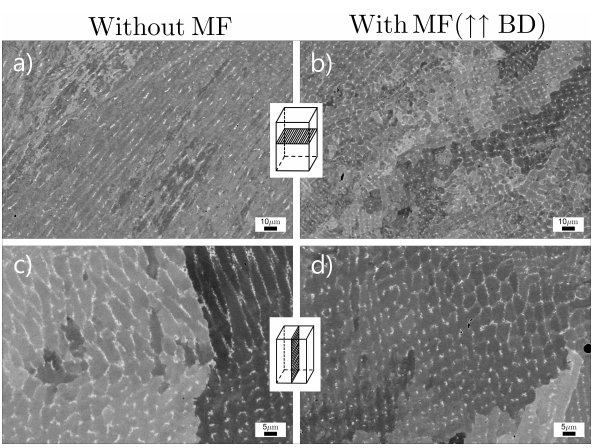
Figure 8. BSE images of the as-deposited Inconel 718 samples in various investigated planes: ( a , b ) top and ( c , d ) front, and no ( a , c ) and with ( b , d ) applied vertical MF. The estimated cell sizes are as follows: ( a ) 5.0 ± 1.0 µm, ( b ) 7.1 ± 1.4 µm, ( c ) 5.2 ± 1.5 µm, and ( d ) 5.2 ± 1.0